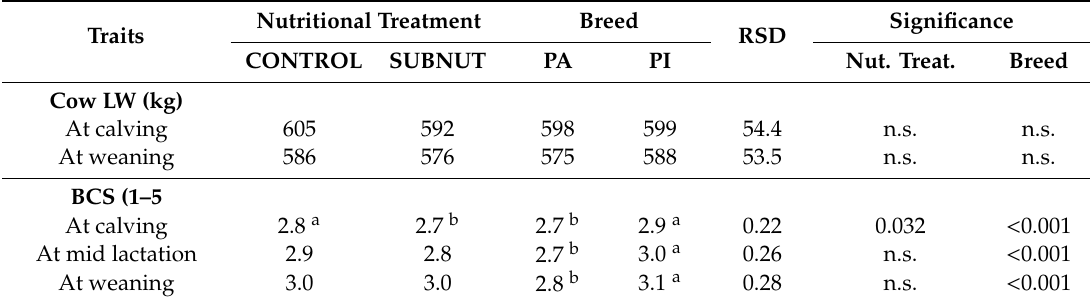
Significance RSD